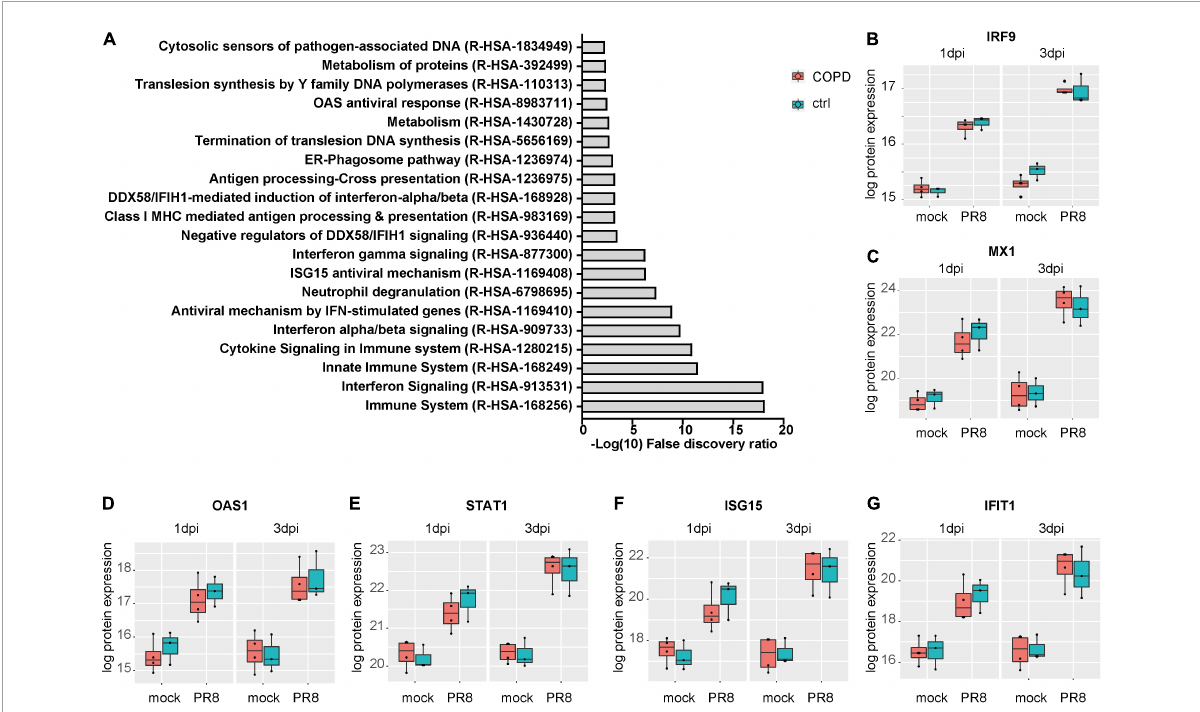
FIGURE4 Upregulation of interferon-regulated pathways and proteins in fully differentiated primary human bronchial epithelial cells (phBECs) independent of disease state post-influenza virus infection. (A) Pathway analysis performed using the tool PANTHER and all 290 differentially expressed proteins post-infection, independent of disease state and taking account of both time points. (B–G) Box plots of interferon-regulated proteins depicting the median (middle horizontal line), the 25 and 75% percentile (lower and upper edge of the box), and the range between largest and smallest value up to a maximum of 1.5 × interquartile range (vertical lines). Data points beyond that range are regarded as outliers and are shown as individual points. IRF9, interferon-regulatory factor 9; MX1, Interferon-induced GTP-binding protein Mx1;